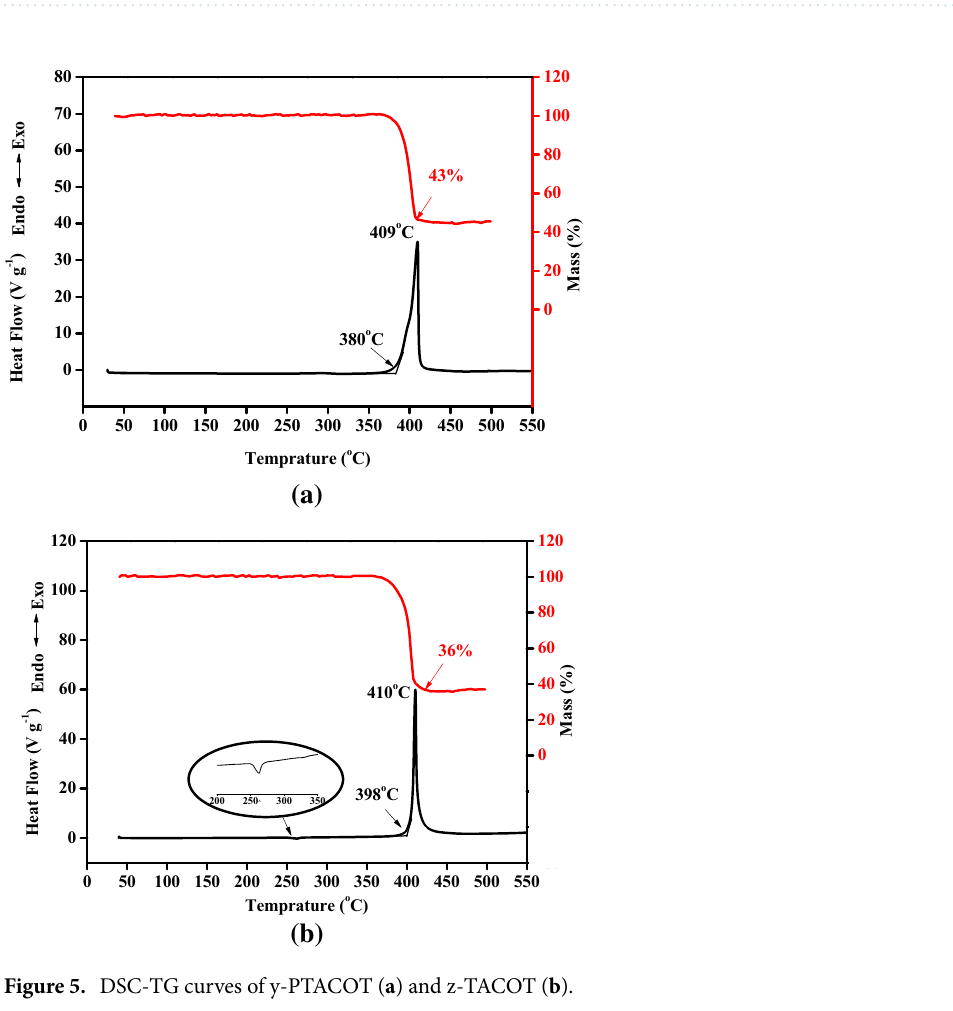
Figure 4. y-PTACOT and z-TACOT structures.